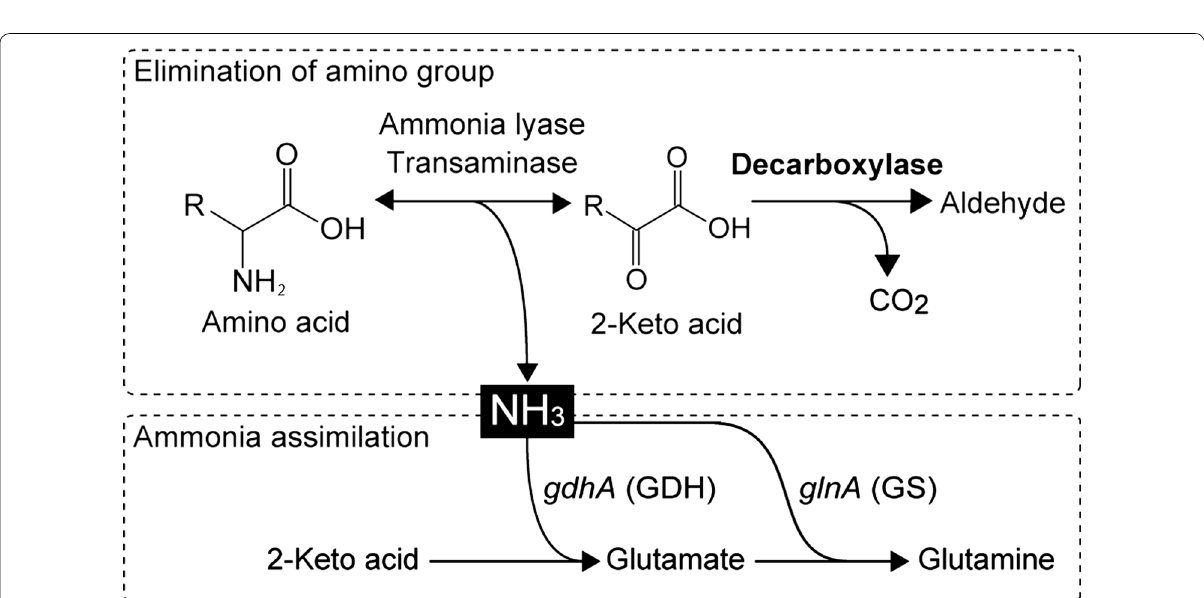
Fig. 3 Scheme of ammonia production. Elimination process of amino groups ( upper ). Assimilation process of amino groups ( lower